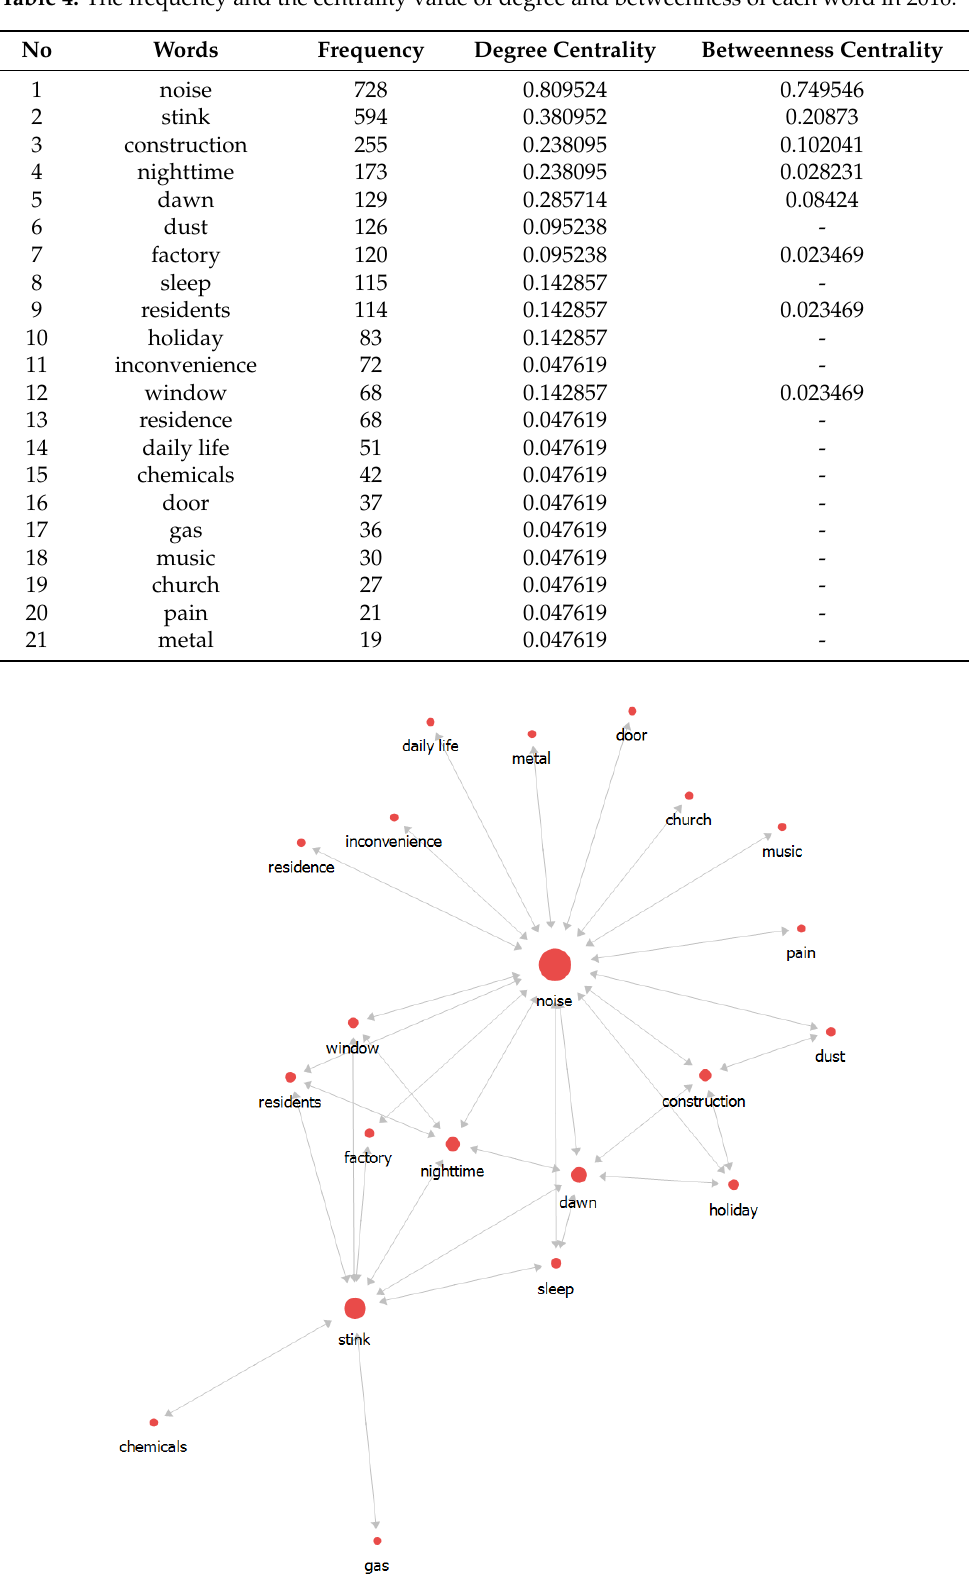
Figure 6. The relationship between words in F igure 6. The relationship between words in 2016.